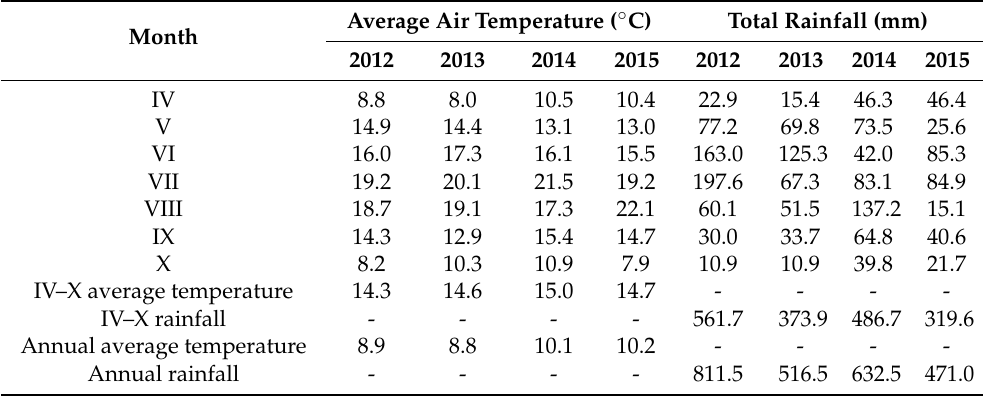
Table 1. Weather conditions during the vegetation period in RGD Brody in the years